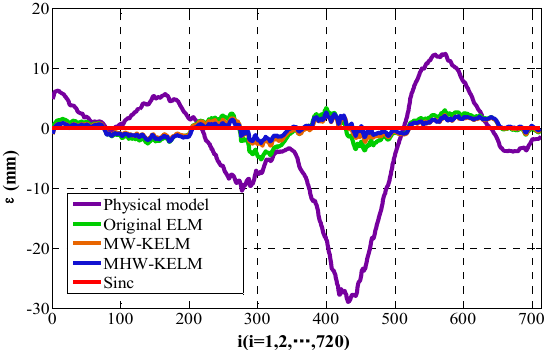
Figure 11. Position error of calibrated Sinc.